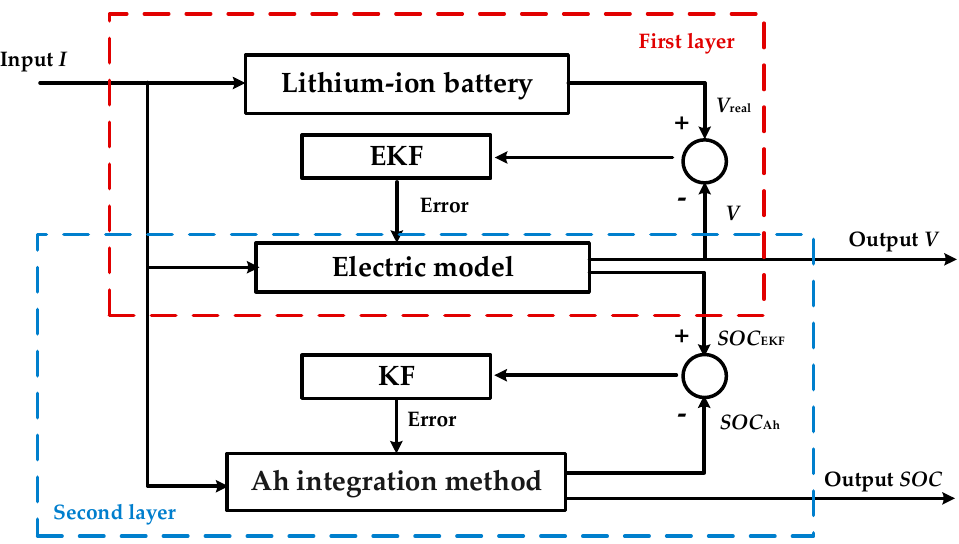
Figure 11. Schematic of the proposed dual Kalman filter (DKF) algorithm for SOC estimation. EKF, extended Kalman filter.